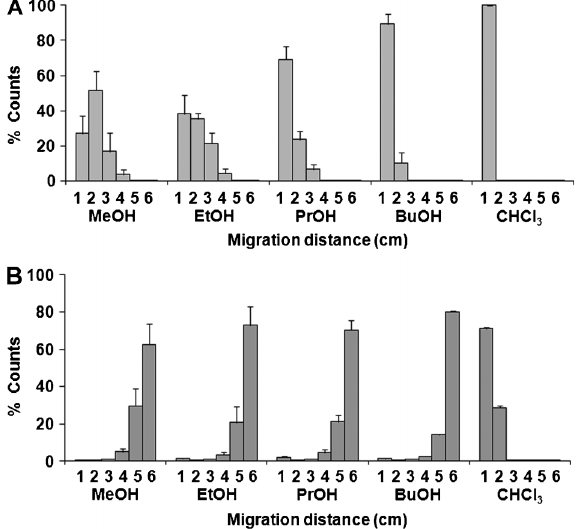
Figure 2. Thin layer chromatography of 99m TcO 4– ( A ) and [ 99m Tc(MIBI) 6 ] + ( B ) reported as percent of counts in segments of the chromatographic strip (cm), numbers 1 to 6. Alcohols (MeOH: methanol, EtOH: ethanol, PrOH: 1-propanol, BuOH: 1- butanol) or chloroform (CHCl 3 ) were used as the mobile phase, and ITLC-SG as the stationary phase. Data are reported as means±SD for